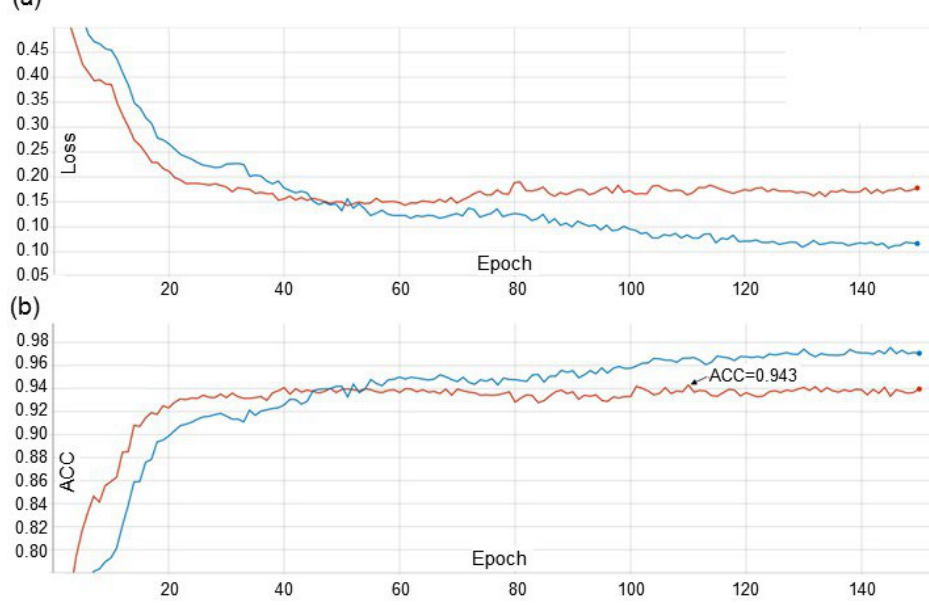
Figure 7. Changes in the loss function ( a ) and ACC accuracy ( b ) from the training epoch of the EfficientNet-B0_FDA model. Blue line—train dataset; red line—validation dataset.